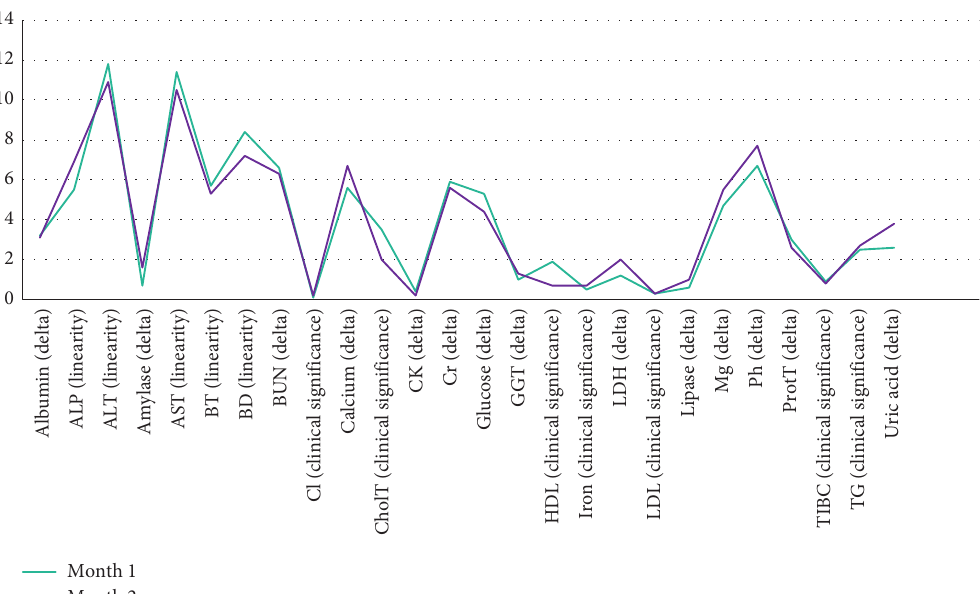
Figure 1: The percentage of each analyte in the total repeated tests and the most common cause of repeat for each analyte in two consecutive months.